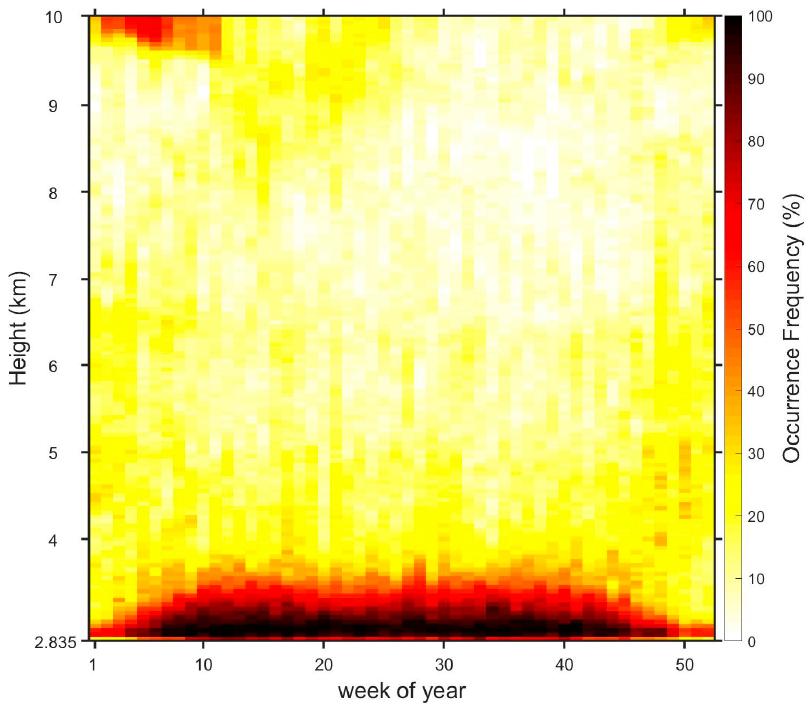
Figure 10. Occurrence frequency of specific humidity inversion layers in weekly slots at each height level up to 10 km during 2005 – 2018.